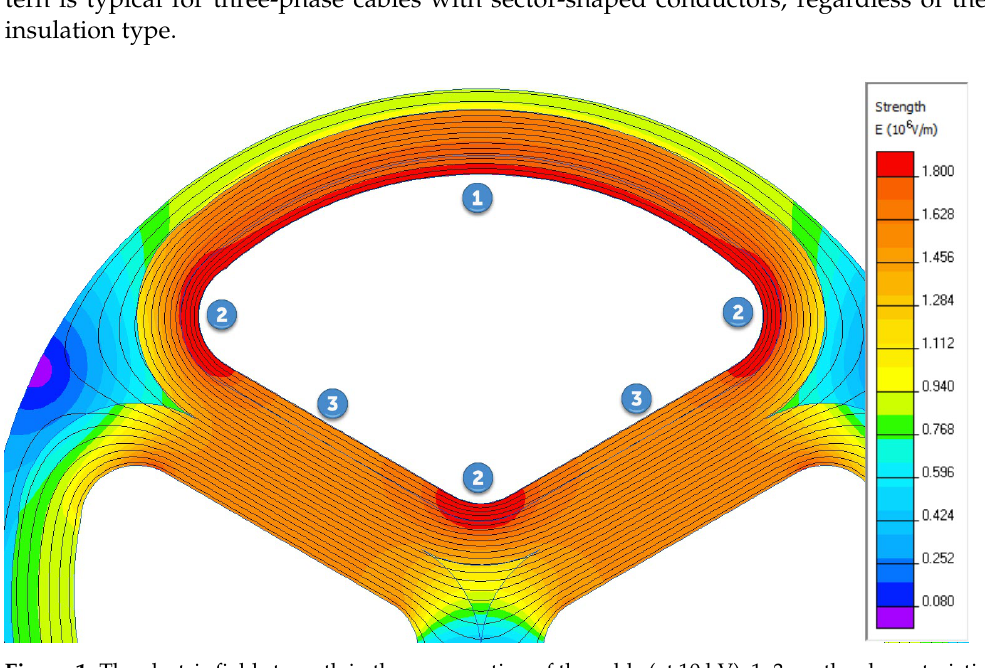
Figure 1. The electric field strength in the cross section of the cable (at 10 kV): 1–3 are the characteristic areas of insulation, while 2 are the areas with the highest electric field strength. The details are explained